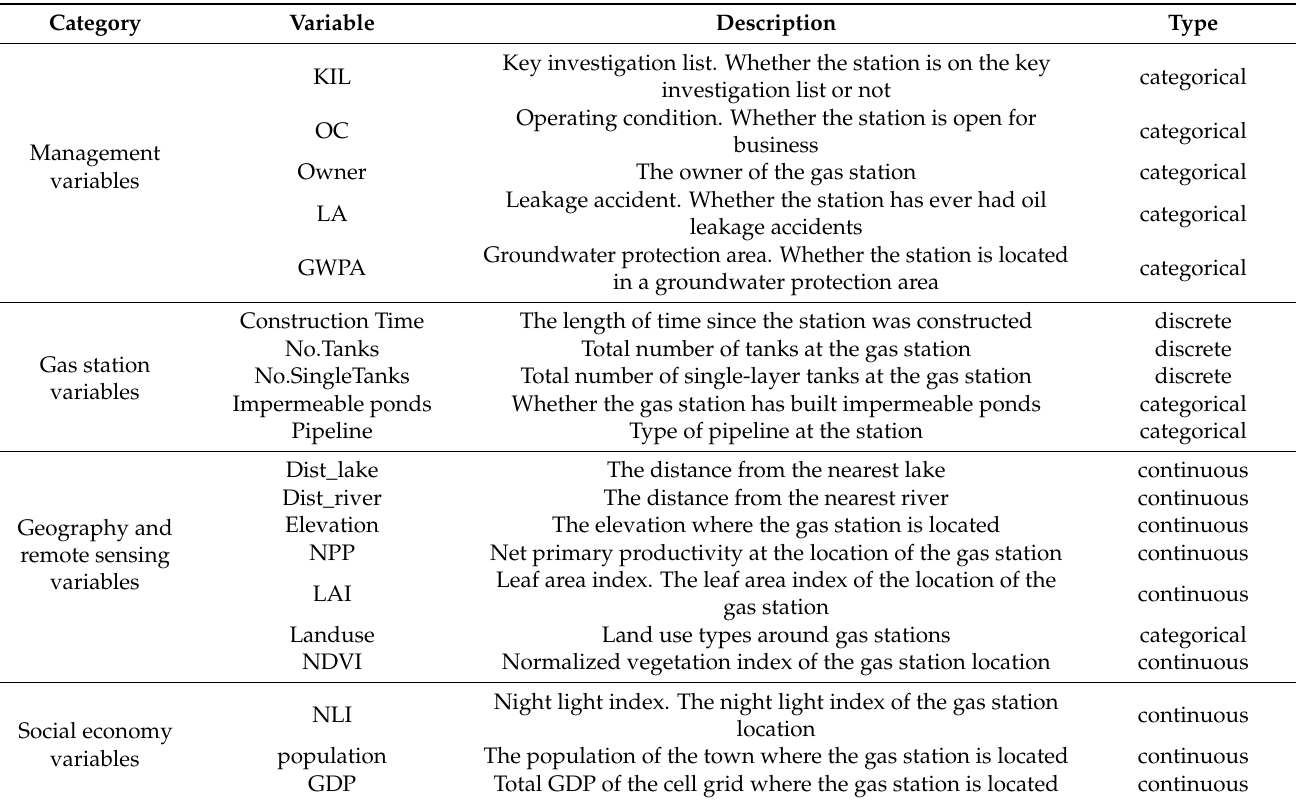
Table 1. Description of feature variables in this